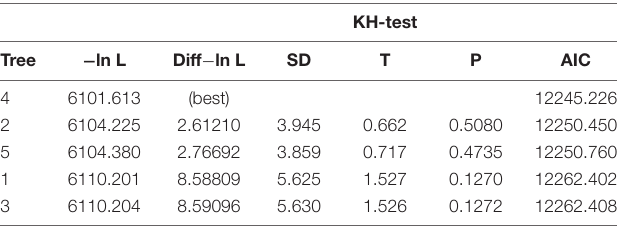
TABLE 1 | Test for significance of likelihood-score differences Kishino-Hasegawa test (KH) using normal approximation, two-tailed test.